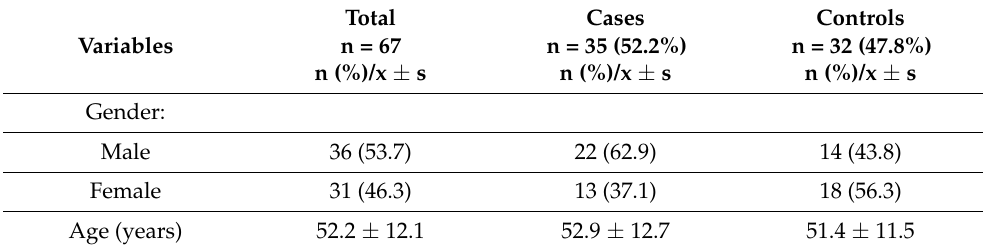
Table 1. Gender and age variables in Total Sample, Cases and Control